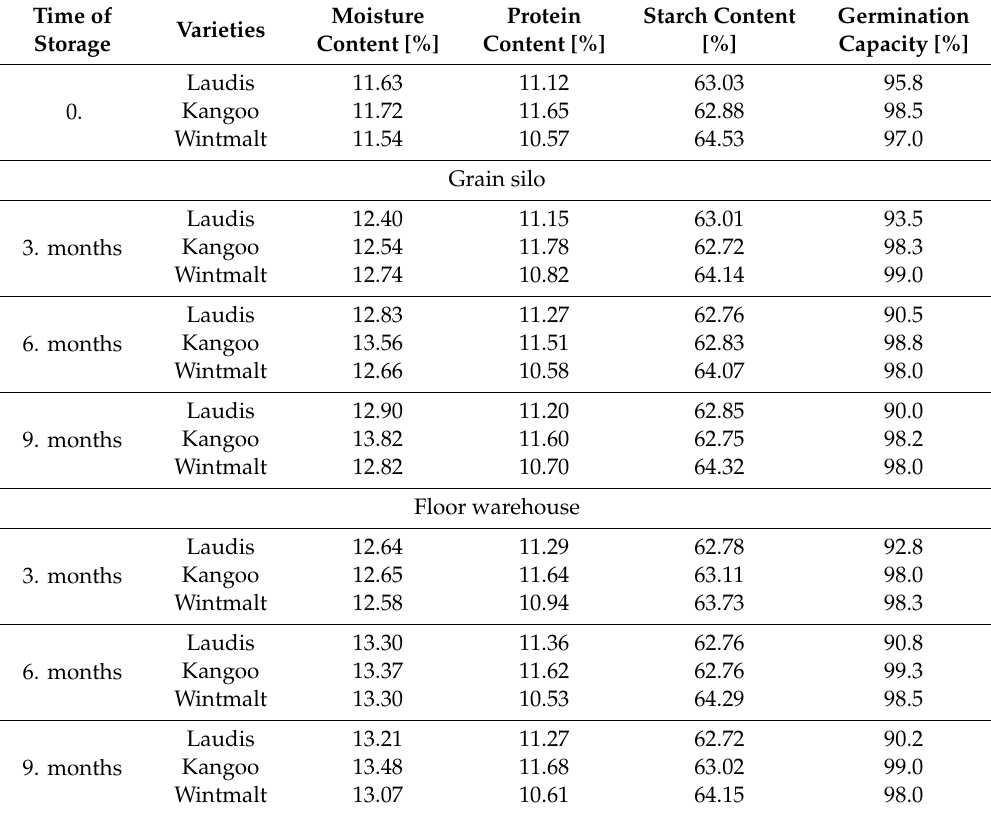
Table 2. Barley basic chemical properties.